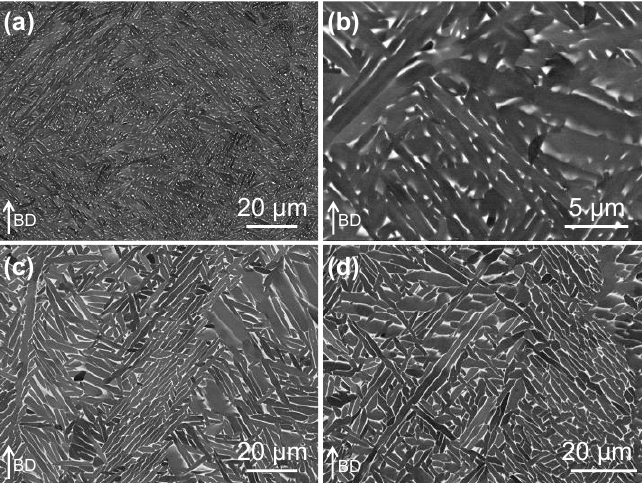
Figure 1. SEM-BSE images of the ( a , b ) as-built, ( c ) HIP, and ( d ) HT specimens.